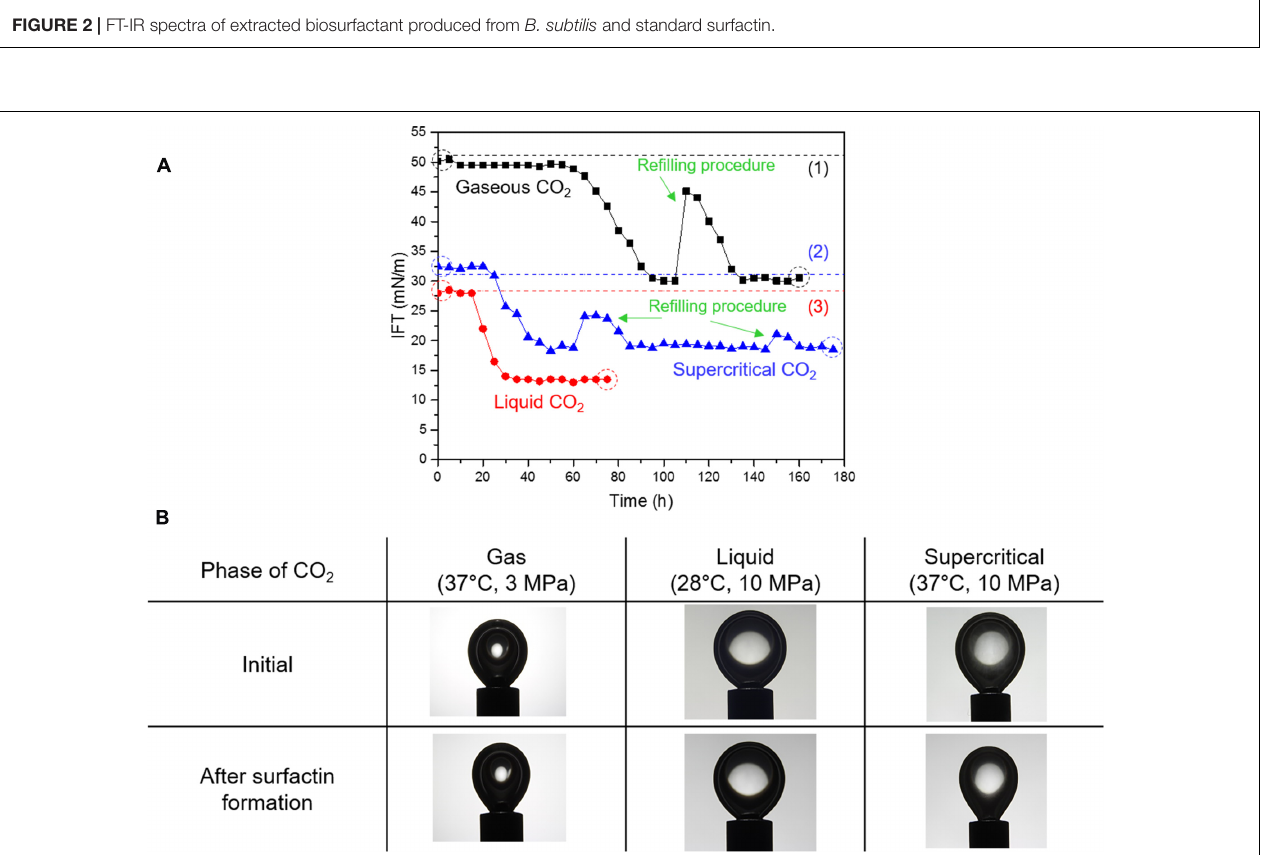
Frontiers in Microbiology |